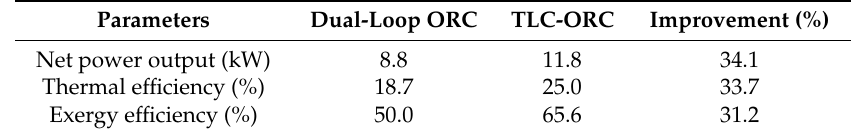
Table 8. Comparison of the maximum output between the dual-loop ORC and TLC-ORC.